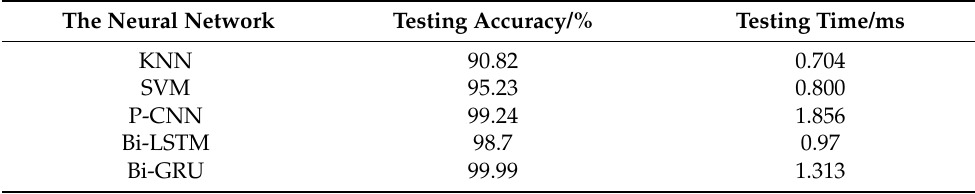
Table 10. Fault diagnosis results of artificial intelligence